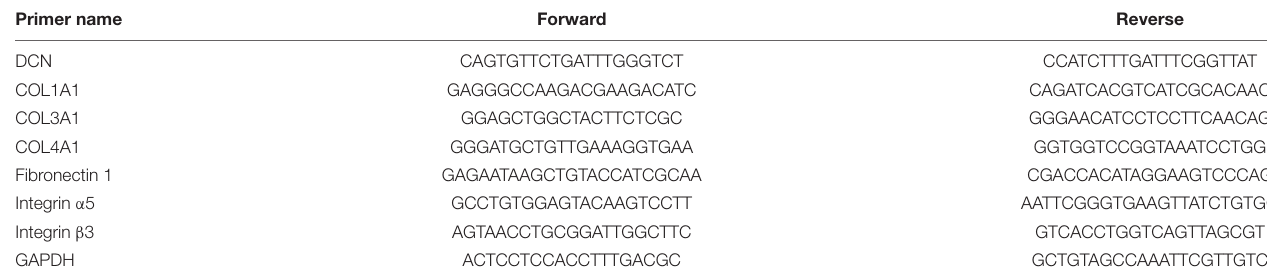
TABLE 1 | Primers used in our